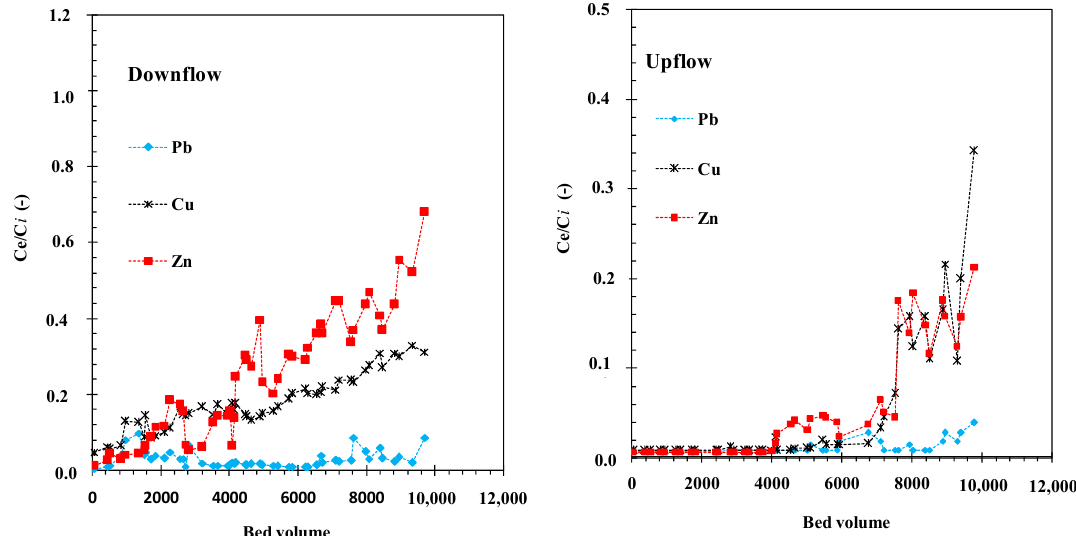
Figure 4. Comparison of breakthrough curves of Cu, Pb and Zn in downflow and upflow mode as a function of bed volume at a volumetric flow rate of 50 mL/min (50% of its maximum saturated flow rate) and filter bed volume of 160 mL. Note that to facilitate visibility of the graph, the Y-axis is different in each case.